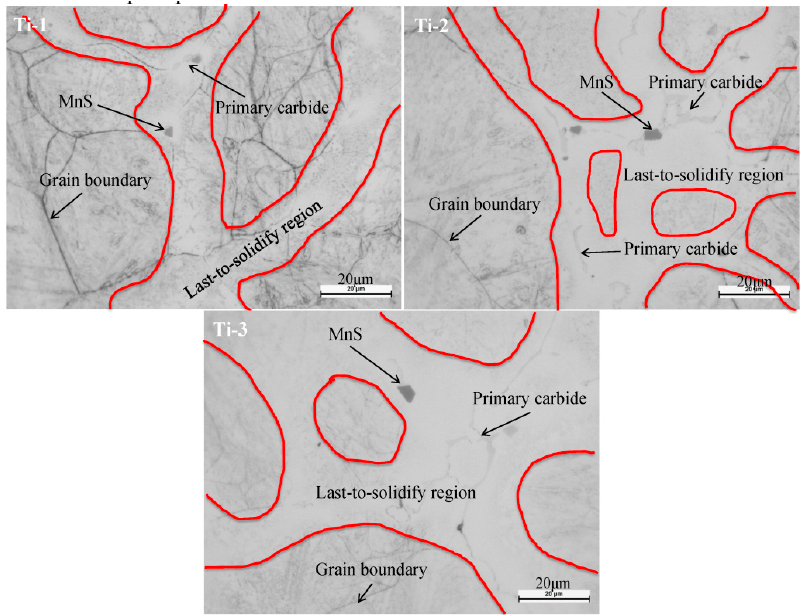
Figure 2. Location of the precipitated inclusions in the Ti-1, Ti-2, and Ti-3 samples.